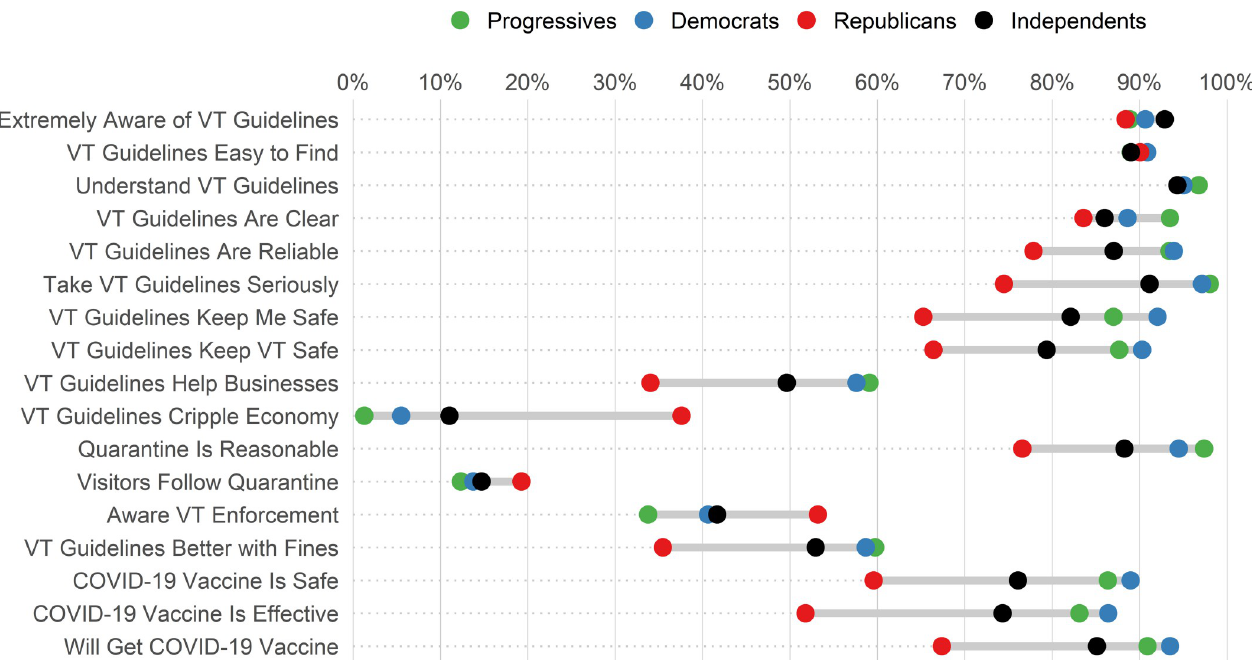
Fig 1. Percent of Vermont residents who responded with awareness and agreement to survey questions, delineated by self-identified political party affiliation, January–April 2021. (Note: The first line reports the percentages of respondents who reported being “Extremely Aware” of VT guidelines; all other lines report the percentage who responded “Agree” or “Strongly Agree” with survey